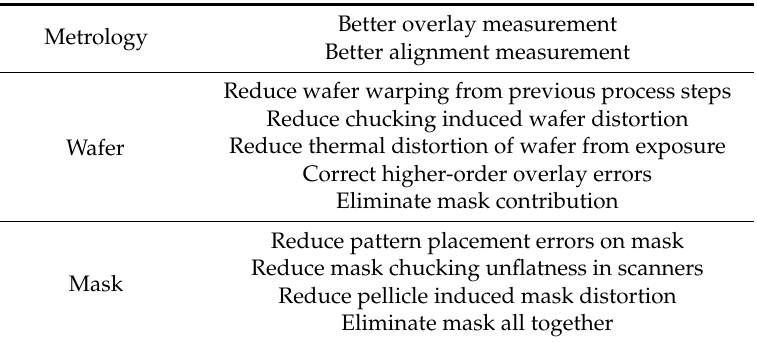
Table 2. Approaches to improve overlay